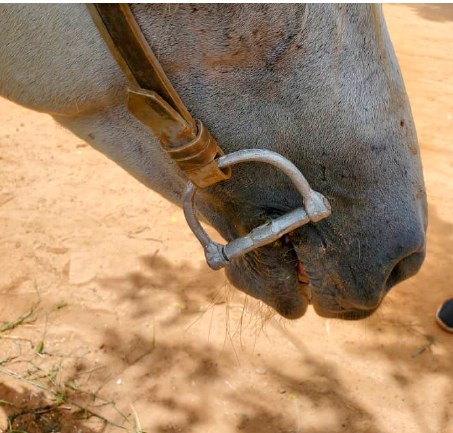
Figure 11. The successful bit prototype fitted to a cart horse’s bridle .